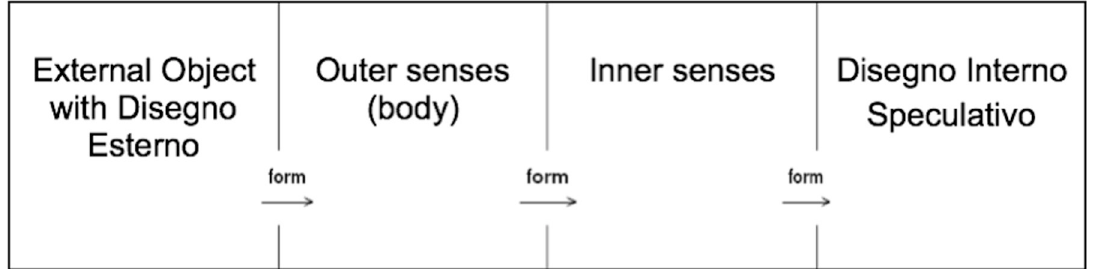
Figure 1: The process of knowledge acquisition according to Federico